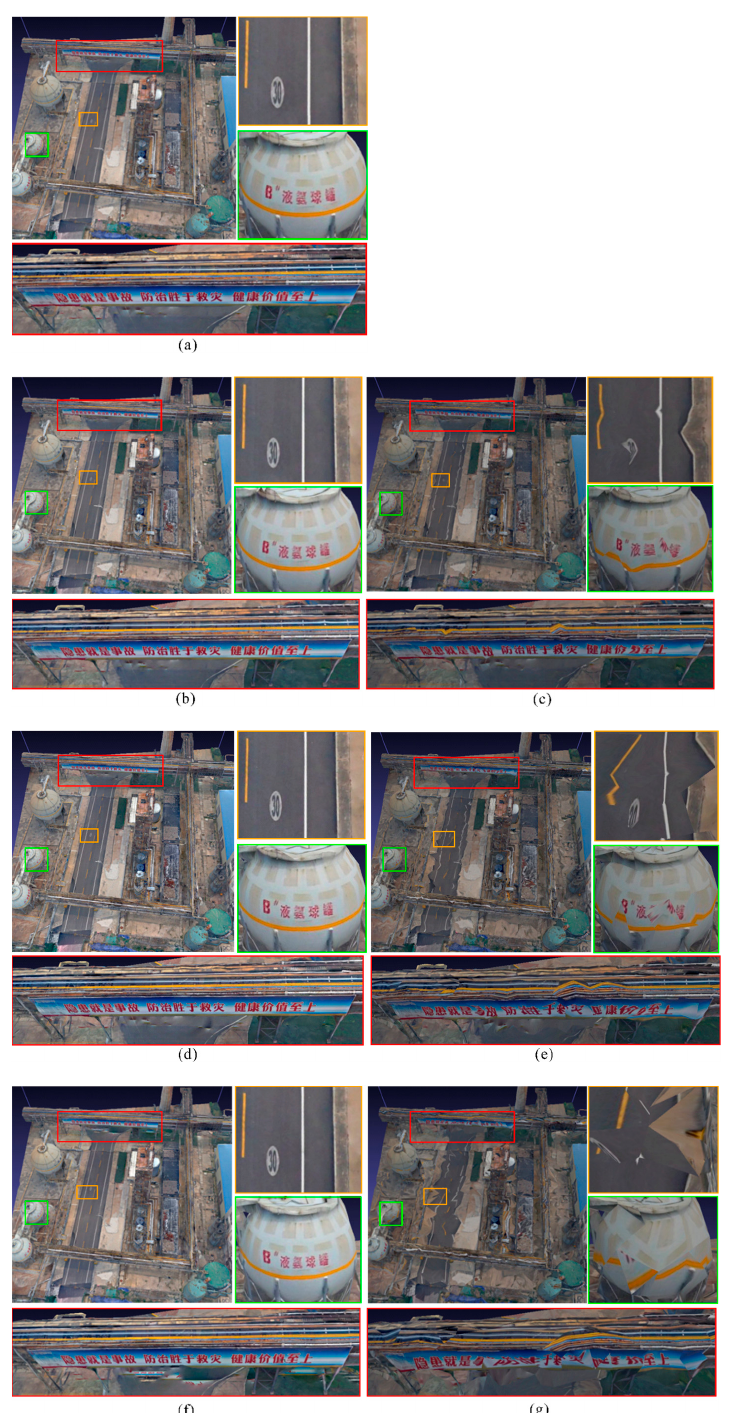
Figure 12. Texture quality comparison of the factory area models. The red, orange and green framework in the overall image represent the corresponding local enlarged drawing around the overall image. ( a ) Original mesh (true value): α = 1.0, β = 1.0, number of facets = 125,288. ( b ) The proposed algorithm: α = 0.50, β = 1.0, number of facets = 62,643. ( c ) The traditional algorithm: α = 0.50, β = 1.0, number of facets = 62,643. ( d ) The proposed algorithm: α = 0.25, β = 1.0, number of facets = 31,321. ( e ) The traditional algorithm: α = 0.25, β = 1.0, number of facets = 31,321. ( f ) The proposed algorithm: α = 0.125, β = 1.0, number of facets = 15,661. ( g ) The traditional algorithm: α = 0.125, β = 1.0, number of facets =